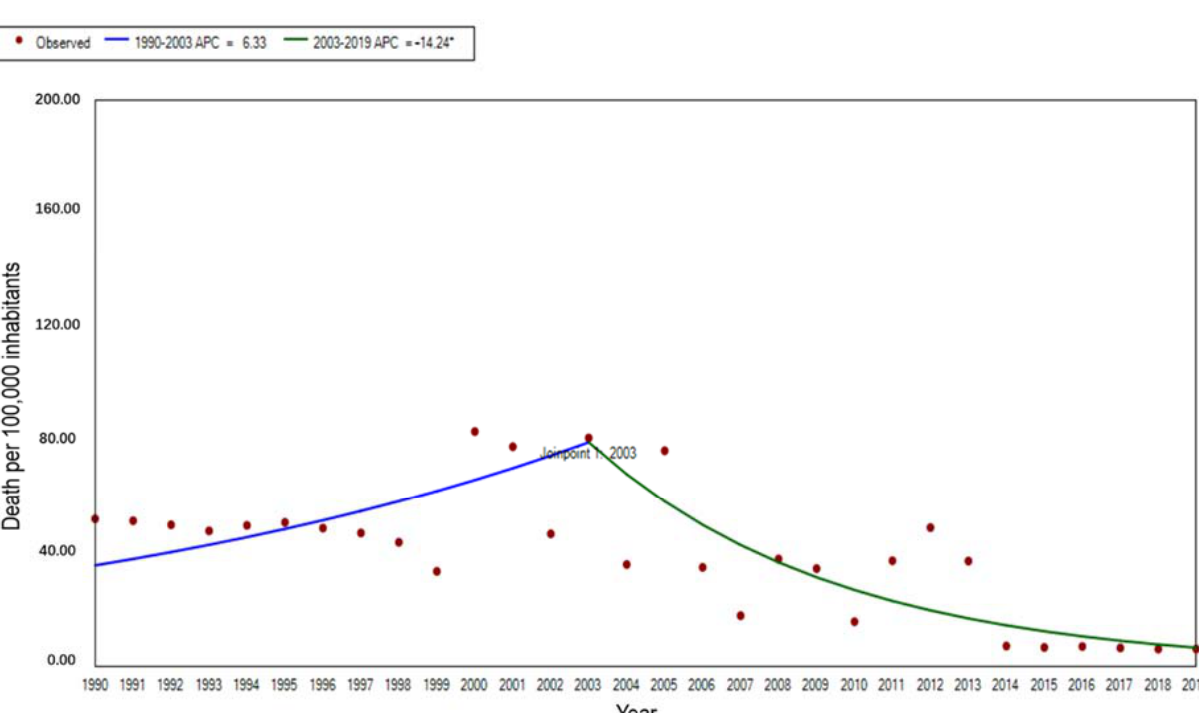
Figure 2. The trend of age-standardized mortality rates for malaria in STP, 1990–2019. Note: * indicates p < 0.05.